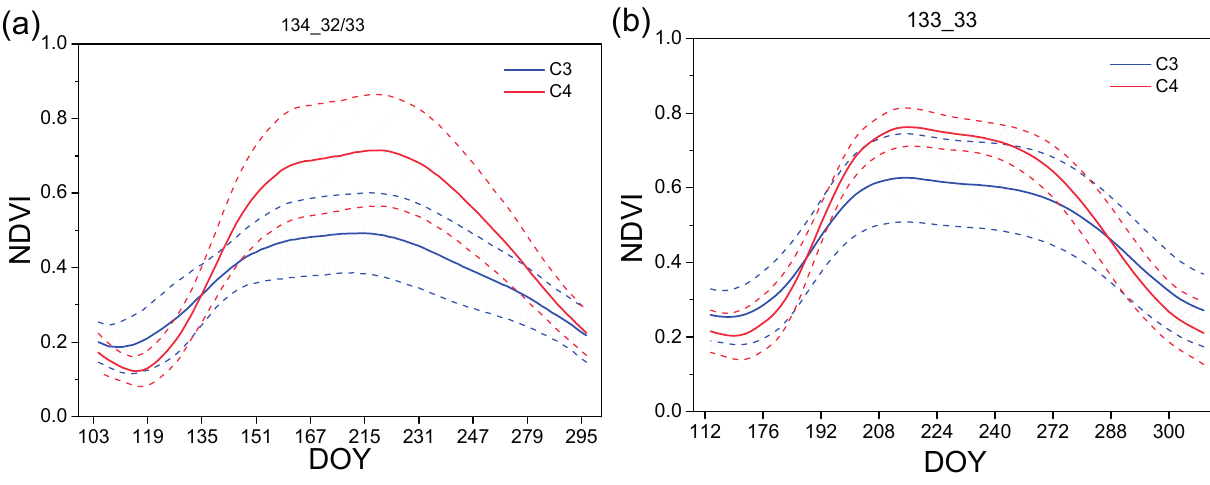
Figure 4. C3 and C4 vegetation distribution as a function of the elevation in the study area.